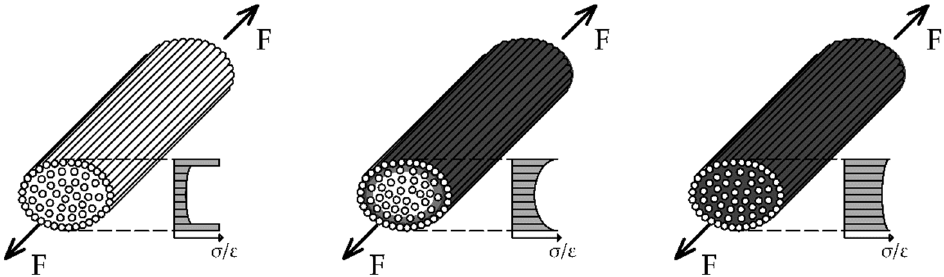
Figure 1. Stress distribution in the cross-section of fiber strands embedded in concrete with different degrees of impregnation, adapted from [15].